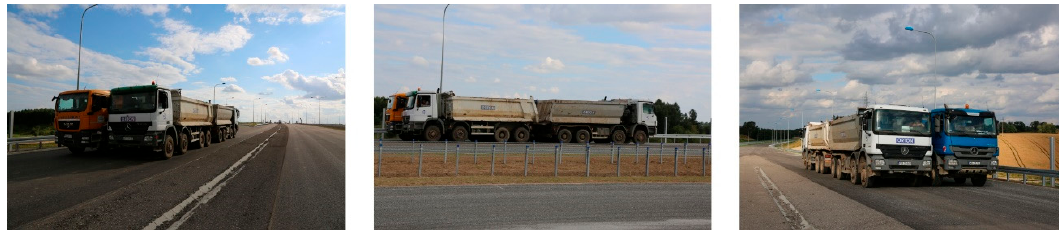
Figure 9. Schematic drawing of trucks locations during the S2 test configuration (dimensions in (m)).